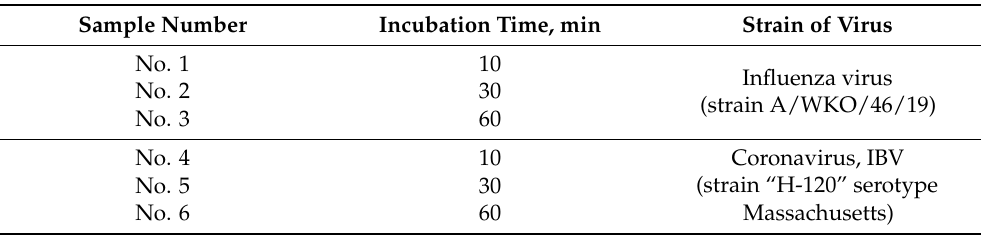
Table 4. Scheme of applying a virus-containing material to the studied samples of self-disinfecting tiles. Sample